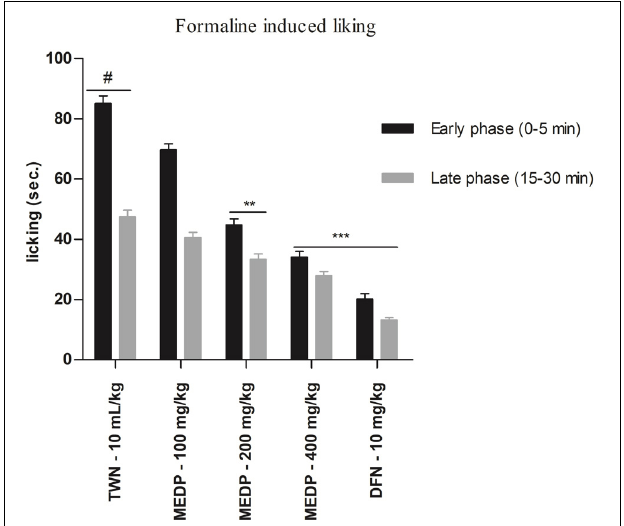
FIGURE 2 | Effects of various test doses of the MELM on the formalin-induced paw licking study in mice ( n = 6). Values are presented as mean ± SEM; one-way ANOVA followed by Dunnett’s test. ** p < 0.01 and *** p < 0.001 were considered as significant compared with the control, where # is designated as control. MEDP = methanol extract of Dillenia pentagyna TWN = 1% Tween-80 and DFN =